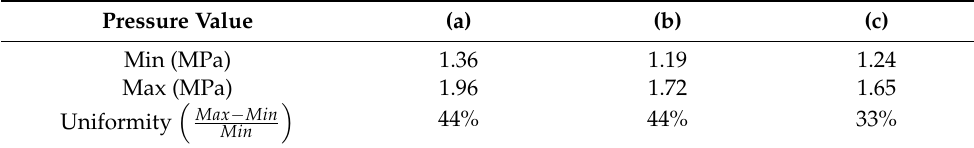
Table 1. Maximum and minimum pressure values and non-uniformity with only the center roller.